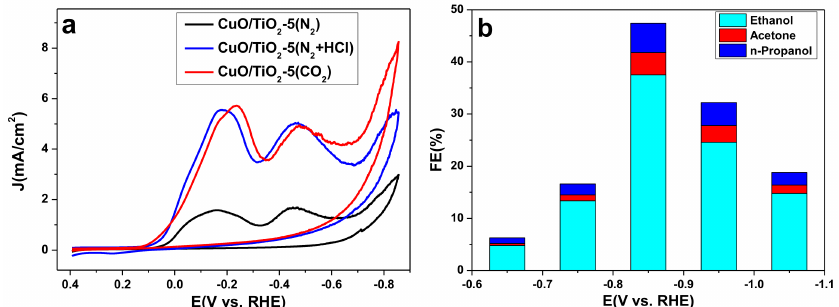
Figure 4. ( a ) CV curves of CuO/TiO 2 -5 catalyst over glassy carbon electrode (GCE) in N 2 -saturated without (black line) and with (blue line) HCl solution, and CO 2 -saturated (red line) 0.5 M KHCO 3 solution; ( b ) FEs for different products over CuO/TiO 2 -5 catalyst at various